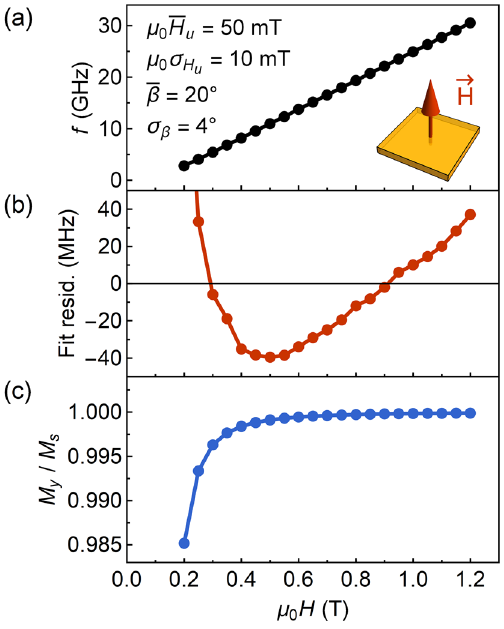
Figure 5. ( a ) Calculated Kittel relation for the out-of-plane magnetic field. Gaussian distributions of uniaxial anisotropy field H u and angle β are specified inside the plot. ( b ) Fit residuals obtained from a fitting of dependency shown in ( a ) with Eq. (4). ( c ) Out-of-plane magnetization component as a function of the magnetic